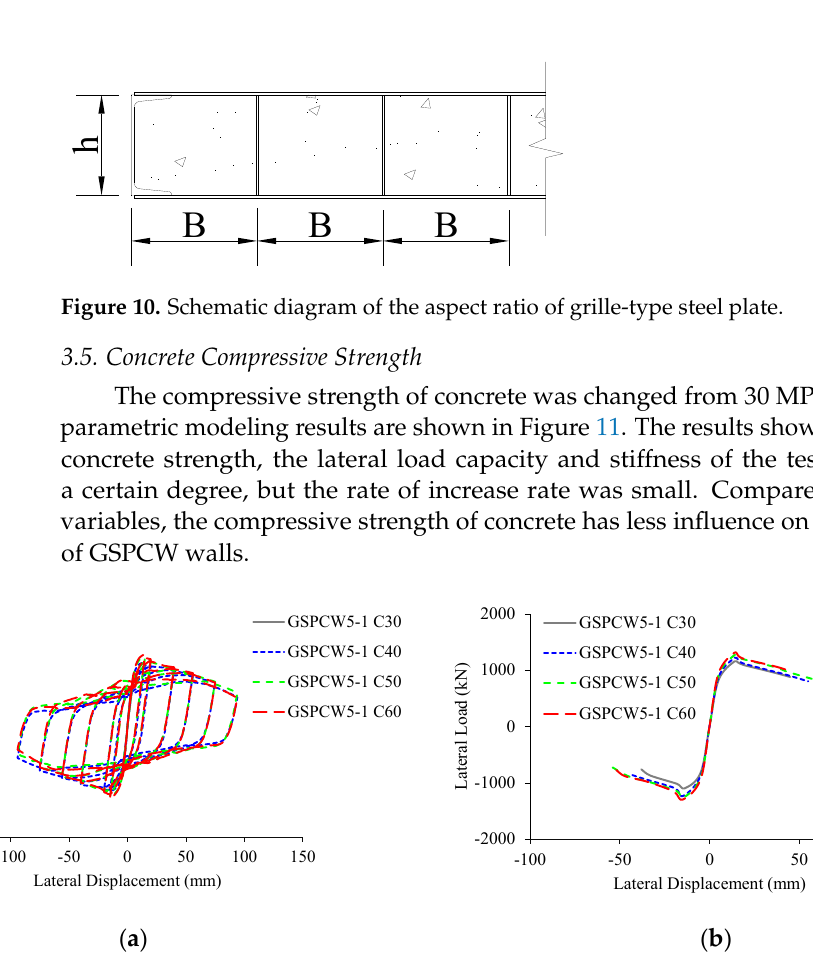
Figure 9. Influence of the aspect ratio of grille-type steel plate: ( a ) load–displacement hysteresis curves, and ( b ) skeleton curves.